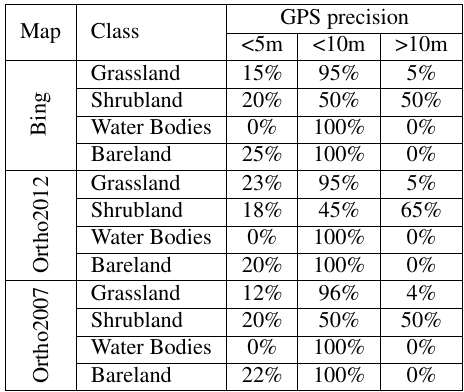
Table 8. Percentage of correctly classified points with respect to distance of observation point